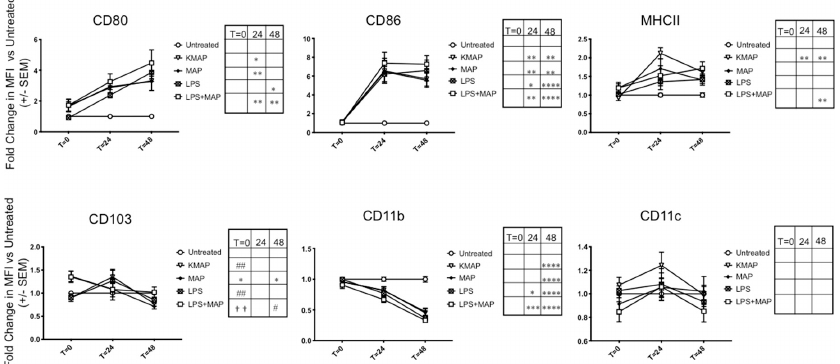
Figure 2. MAP infection delays maturation of moDCs. moDCs (1.8 × 10 4 cells) were untreated or infected / treated with the same number of opsonized MAP, antibiotic-killed MAP (KMAP), MAP +